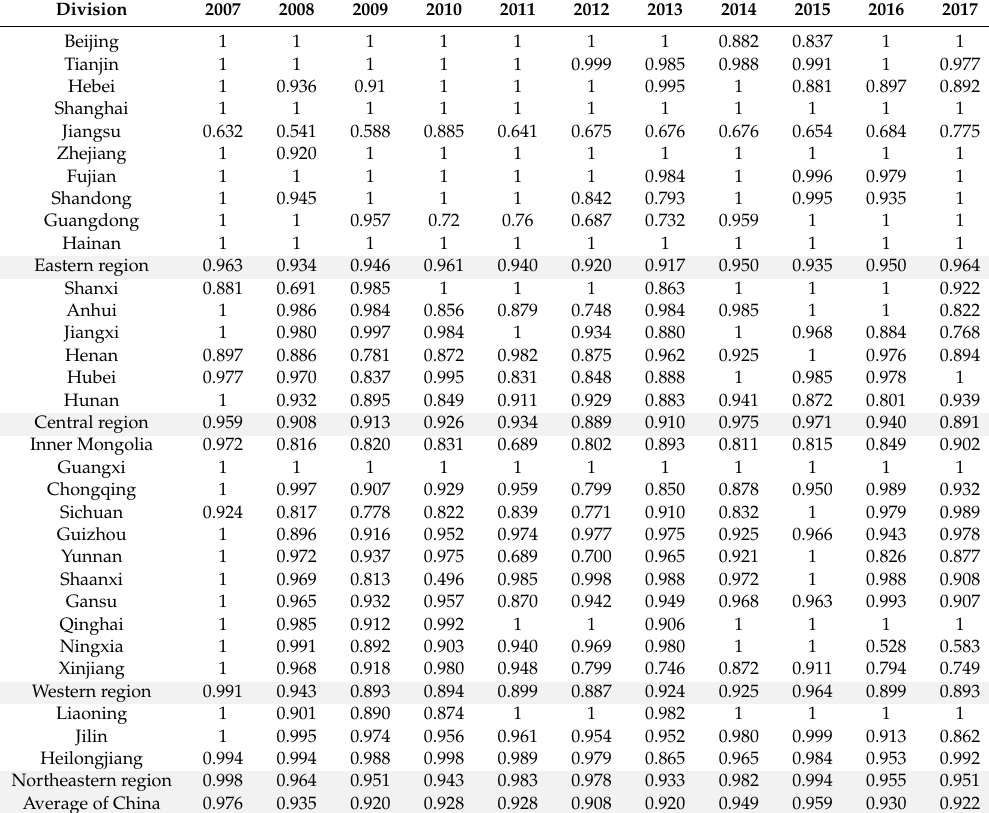
Table A4. Scale e ffi ciency values of fiscal policies for environmental pollution control in China